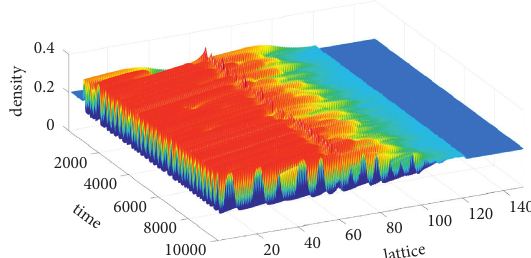
Figure 11: Spatiotemporal evolution pattern.